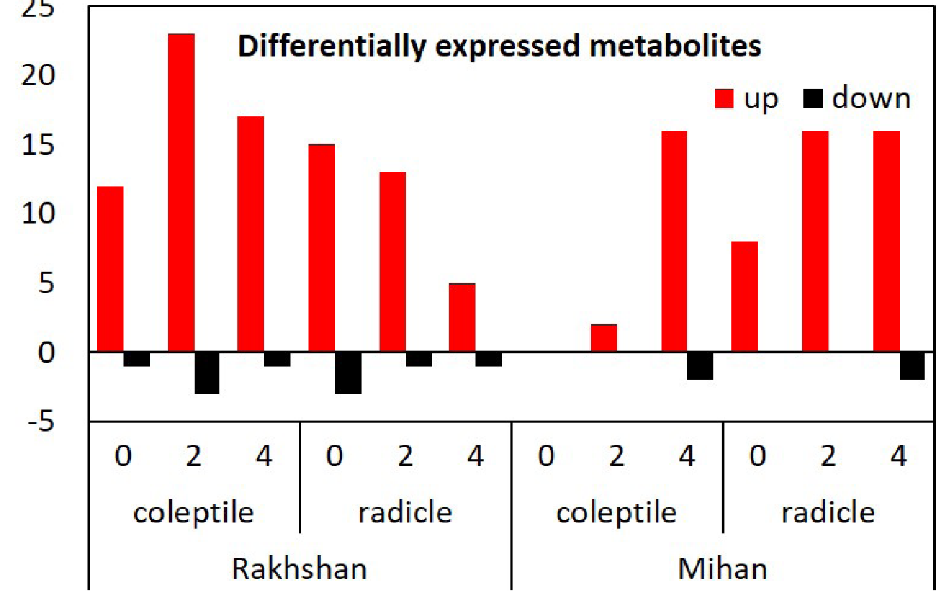
Figure 10. Number of the differentially expressed metabolites in two varieties (Mihan and Rakshan) under PEG 6000 treatments. 0, 2, and 4 indicates control, −2 MPa, and −4 MPa PEG treatments, respectively. Up: statistically significant increased, down: statistically significant decreased levels.